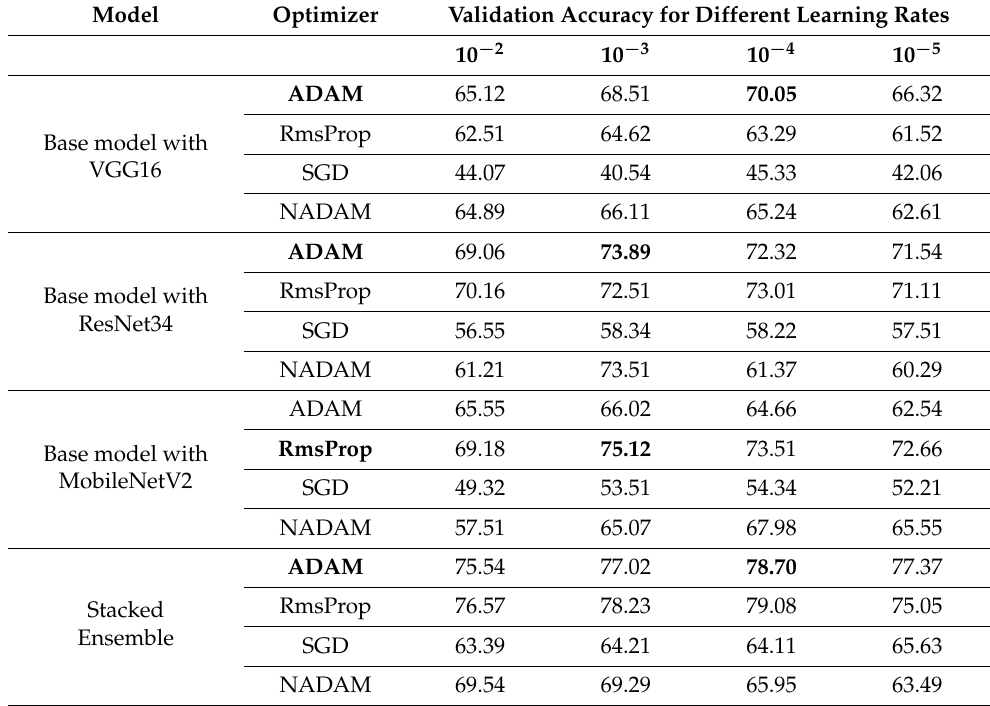
Table 2. Hyperparameter Tuning Results. Best results achieved for each classifier is shown in